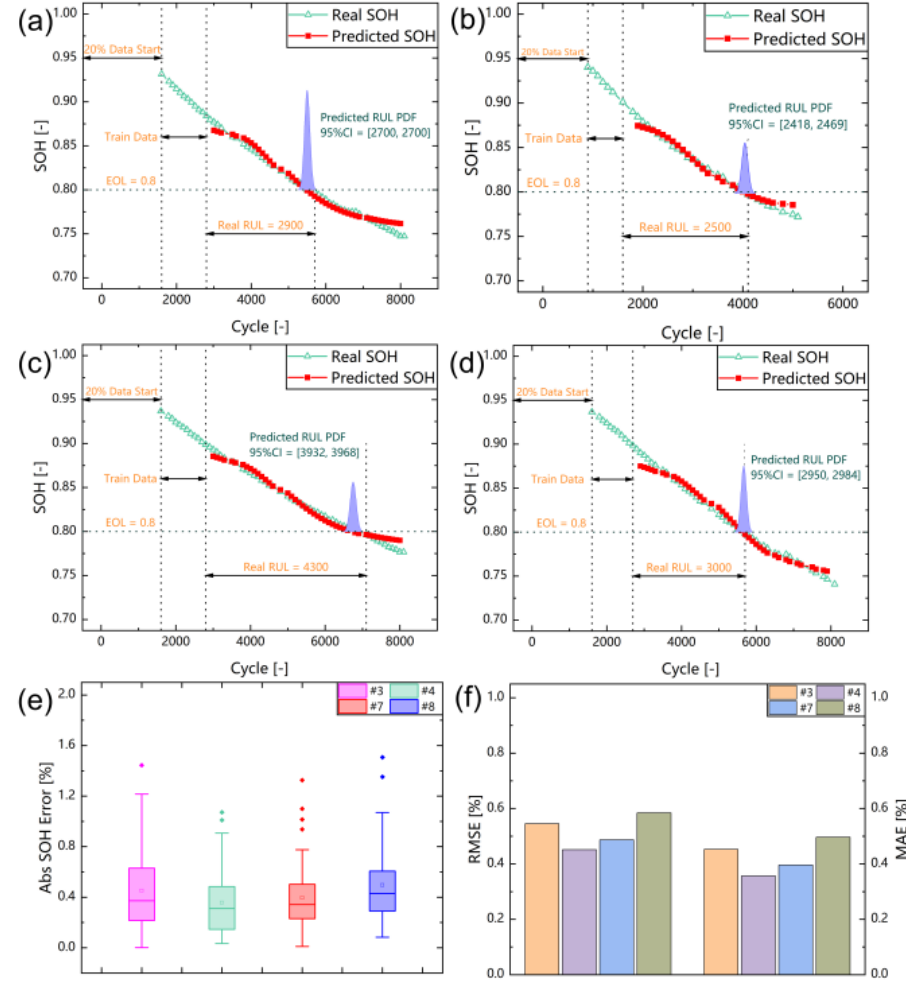
Figure 10. Validation of robustness of the proposed model. ( a ) Estimation results for battery #3. ( b ) Estimation results for battery #4. ( c ) Estimation results for battery #7. ( d ) Estimation results for battery #8. ( e ) Box-plot analysis for four batteries. ( f ) RMSE and MAE analysis for four batteries.